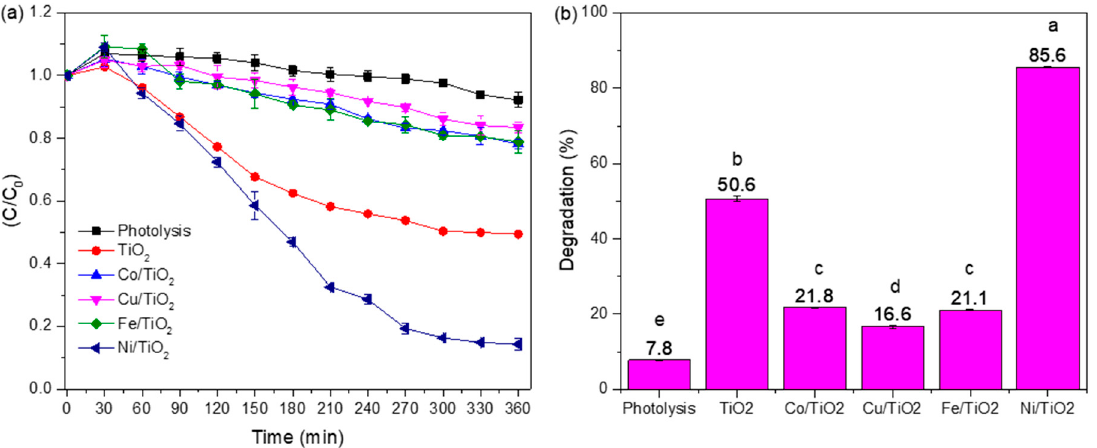
Figure 12. Degradation activity of 2,4-D ( a ) and percentage of degradation after 6 h of reaction ( b ). For the plot ( b ), all values are mean ± standard deviation of three determinations. Different letters in each column indicate significant statistical differences between treatments ( p < 0.05).